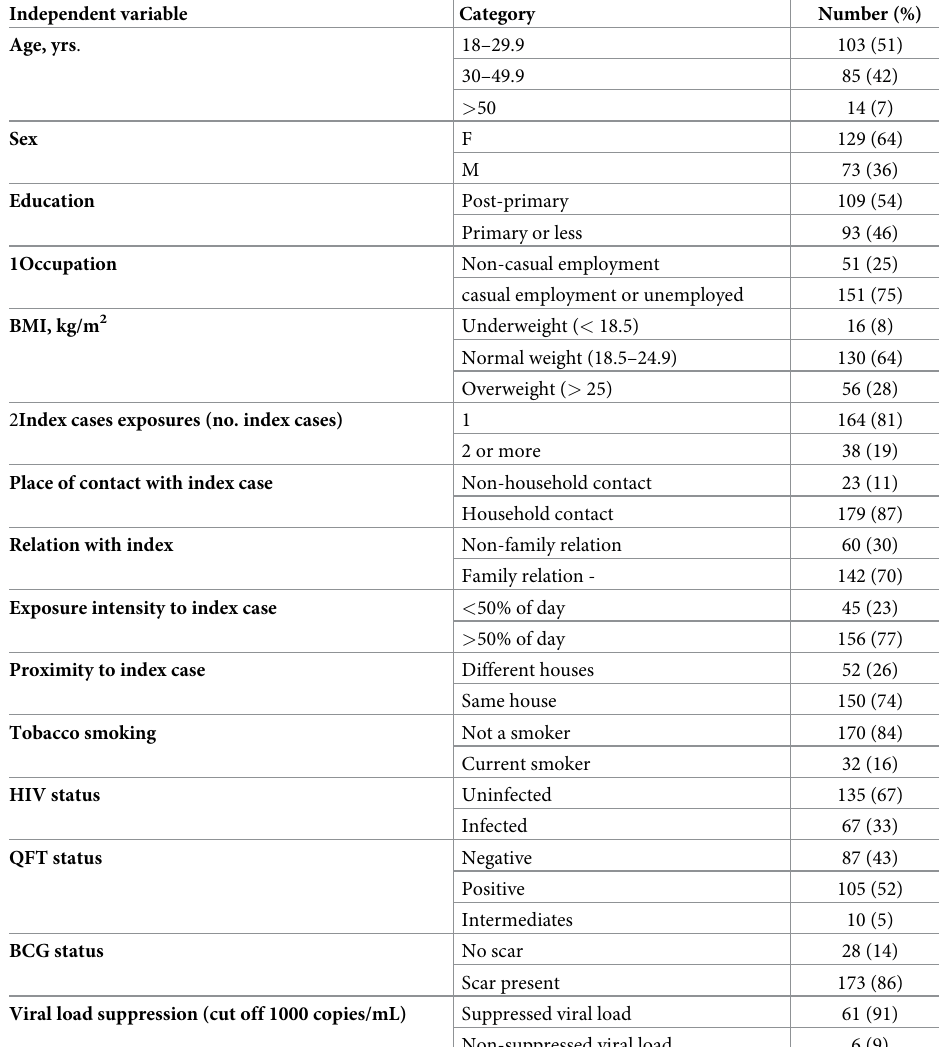
Table 1. Participant characteristics (n =